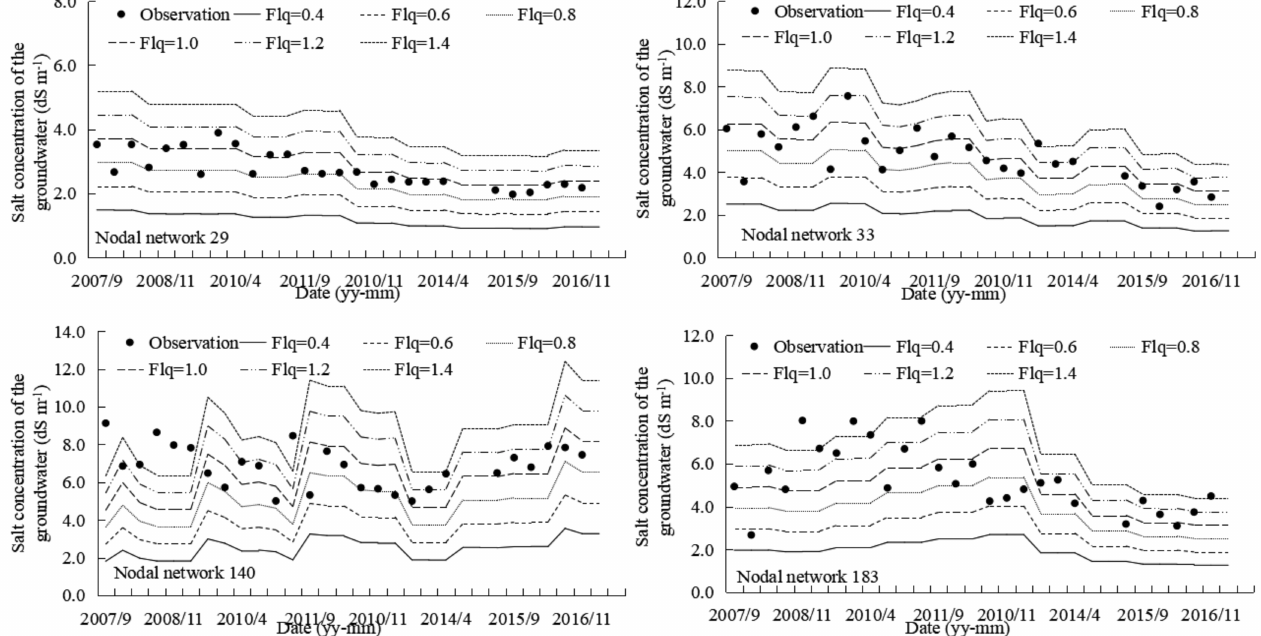
Figure 6. Calibration of the leaching efficiency in the aquifer zone (Flq) for